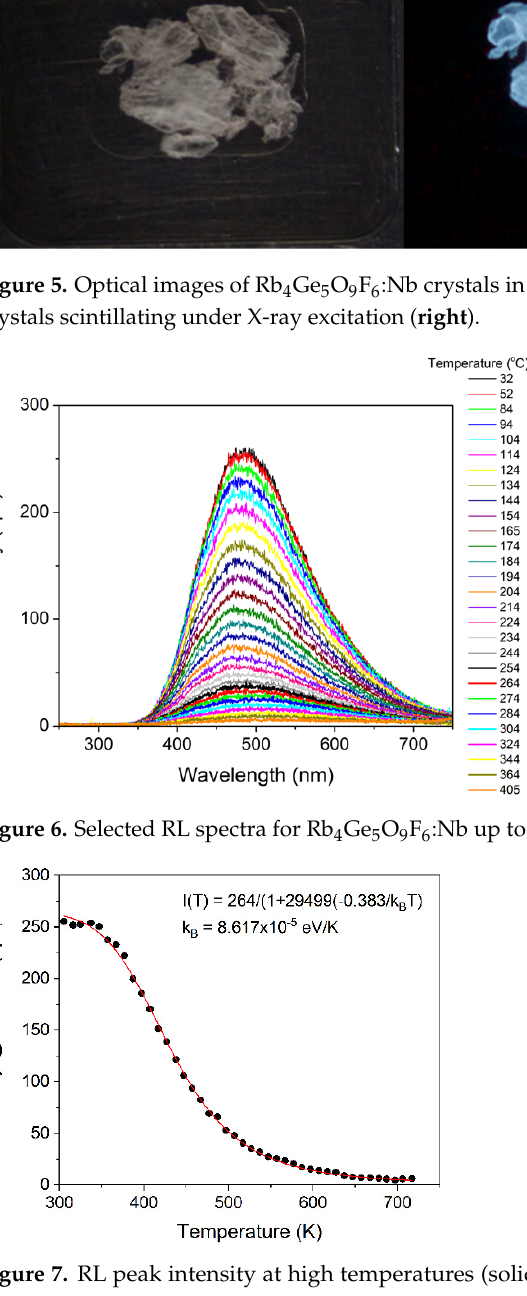
Figure 7. RL peak intensity at high temperatures (solid circles) together with fitting based on the Mott-Seitz model (red line).